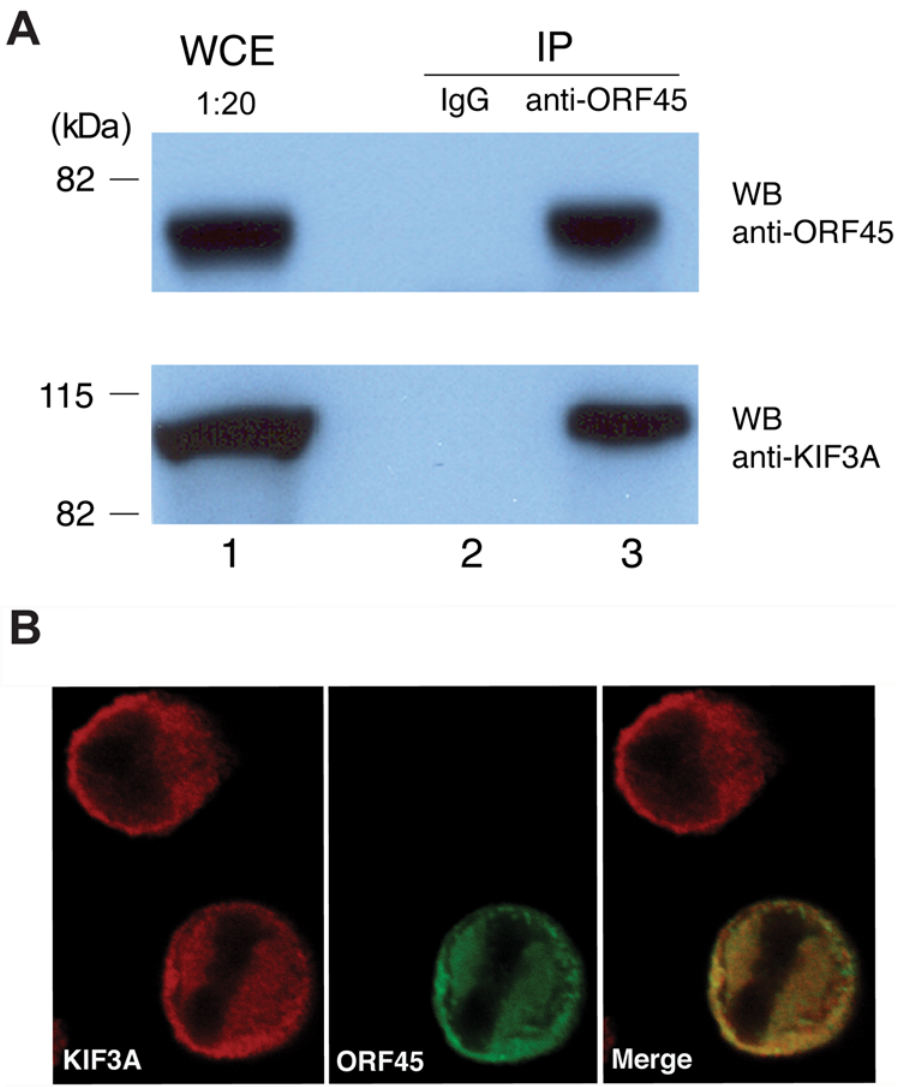
Figure 1. Interaction of KSHV ORF45 with KIF3A. (A) BCBL-1 cells induced with TPA for 48 hours were lysed, and whole cell extracts (WCE) were immunoprecipitated (IP) with mouse IgG (negative control) or mouse monoclonal anti-ORF45 antibody. The immunoprecipitates were analysed by Western blotting (WB) with anti-ORF45 (upper panel) and anti-KIF3A antibodies (lower panel). Positions of the molecular mass standards (kDa) are shown toward the left. (B) BCBL-1 cells treated with TPA for 48 hours were fixed and permeabilized. Cells were subjected to double-labeled IFA using rabbit-polyclonal anti-KIF3A (red) and mouse monoclonal anti-ORF45 (green). The merged image is also shown.